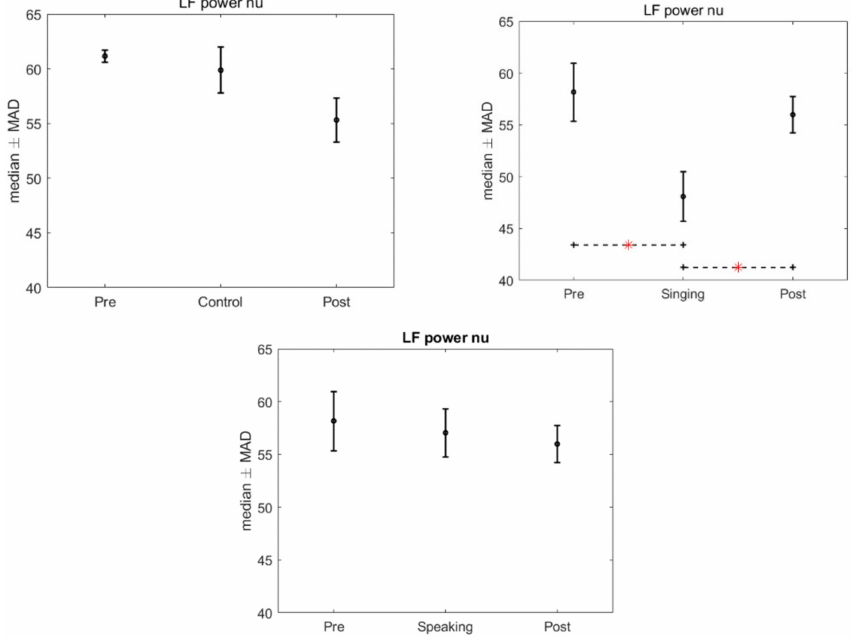
Figure 3. Median and MAD of LF power nu for the different time conditions related to control, singing, and speaking groups. The asterisk indicates the significant comparisons observed after we used Bonferroni’s test for post hoc